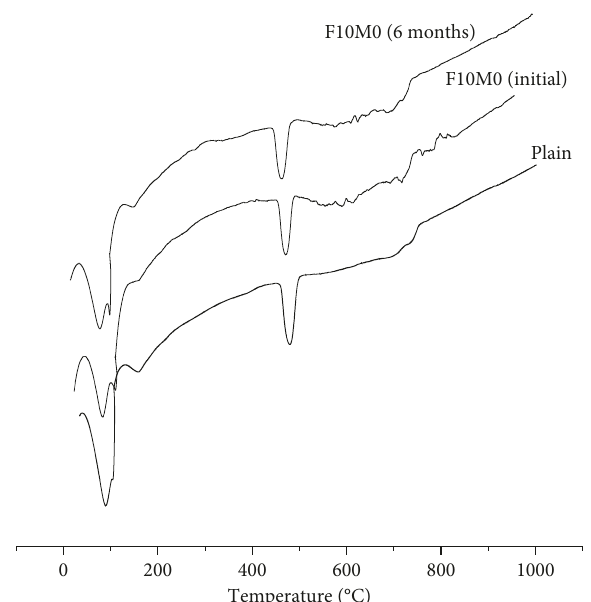
Figure 4: TG-DTA graph for RMAP with cement after 3 days.